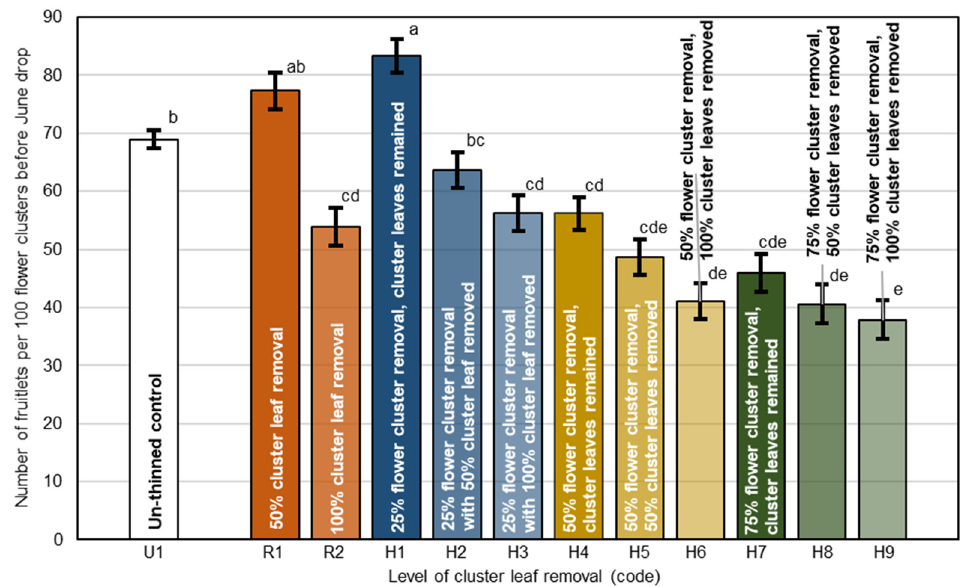
Figure 4. Effect of source ‐ sink modification, such as cluster leaf and flower cluster removal, on fruit set expressed as number of fruitlets per 100 flower clusters before June drop (white, un ‐ thinned control; brown, cluster leaf removal; blue, yellow, and green are 25%, 50%, and 75% flower cluster removal, respectively; all with/without cluster leaf removal) (different letters denote statistically significant differences at the 5% level).